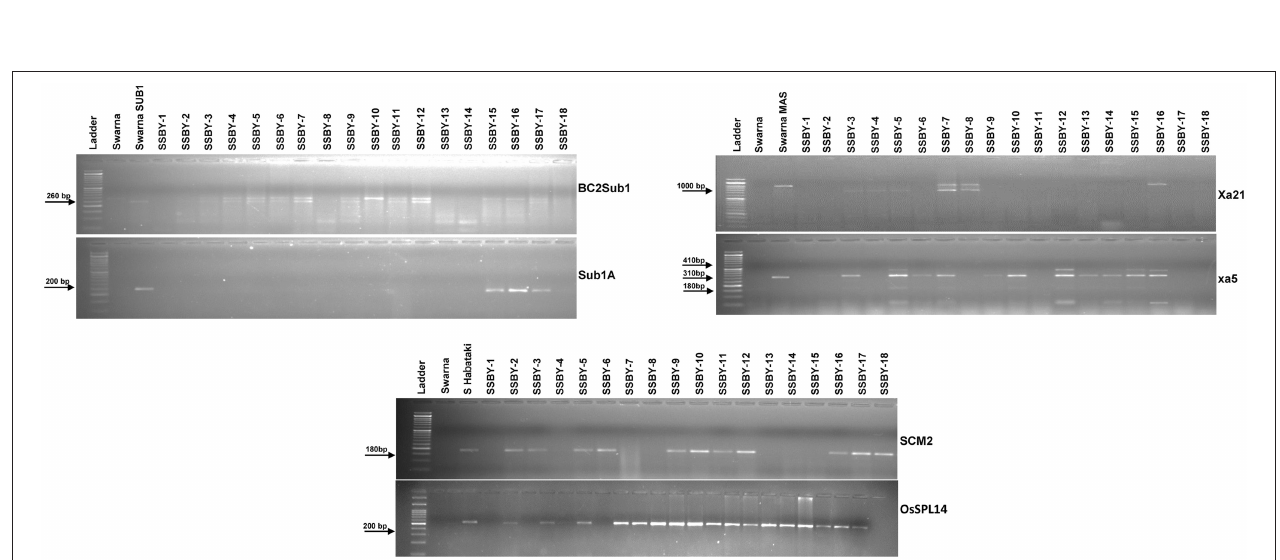
FIGURE 2 | Representative electropherogram of BC 1 F 1 progenies in the Swarna background for submergence tolerance QTL Sub1A , bacterial blight resistance gene xa5 and Xa21 and yield component QTLs, OsSPL14 , and SCM2 . The designations on the top of the lane indicate the genotype used. L:100 bp DNA ladder.